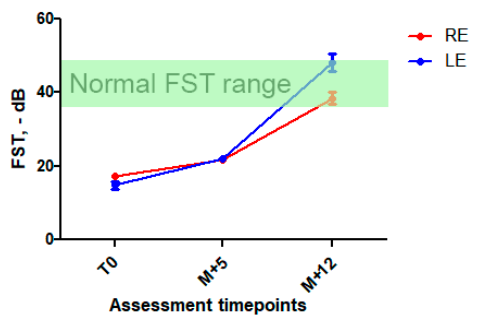
Figure 3. Full stimulus threshold before and after high-dose vitamin A intake. Mean FST ± SD at first assessment, at M + 5 and M + 12 follow-up. A significant improvement in FST was observed at M + 5 (25 and 40% decrease) and was sustained at M + 12 (123 et 215% in RE and LE, respectively). In green, normal FST range [42, 43].